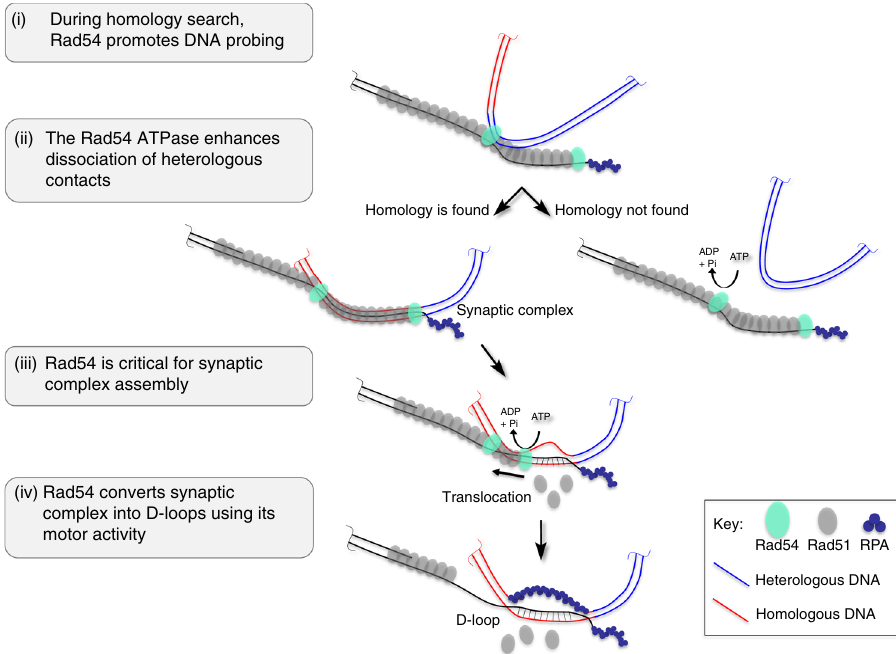
Fig. 6 Rad51 and Rad54 cooperative model for homology search and D-loop formation. (i) During homology search, Rad54 promotes DNA probing. The invading DNA (light red) uses Rad54 to bridge the Rad51 fi lament to dsDNA during the homology search. Rad54 ATPase activity is not required but may enhance probing. (ii) Persistent associations with heterologous DNA (blue, right arrow) may be prevented or dissociated by Rad54 in an ATPase- dependent fashion. Rad54 ATPase exerts quality control to promote homologous pairing. (iii) Rad54 is required for synaptic complex formation without strict requirement for ATPase activity, and (iv) converts such complexes into D-loops dependent on ATP hydrolysis. Rad51 left on the ssDNA outside of the heteroduplex region after removal during heteroduplex formation may able to repolymerize back into the synaptic region. Note that this is a cartoon representation not meant to model the true scale and structure of the Rad51 fi lament or Rad54 protein arrangement in the depicted